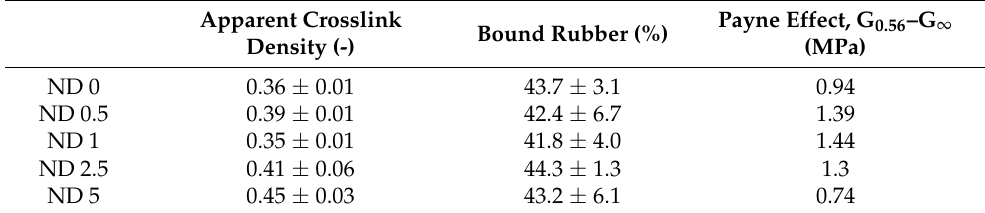
Figure 1. Rheometric curves of NR/BR compounds at different ND/CB concentrations. Table 2. Apparent crosslink density, bound rubber content and the Payne effect of the rubber